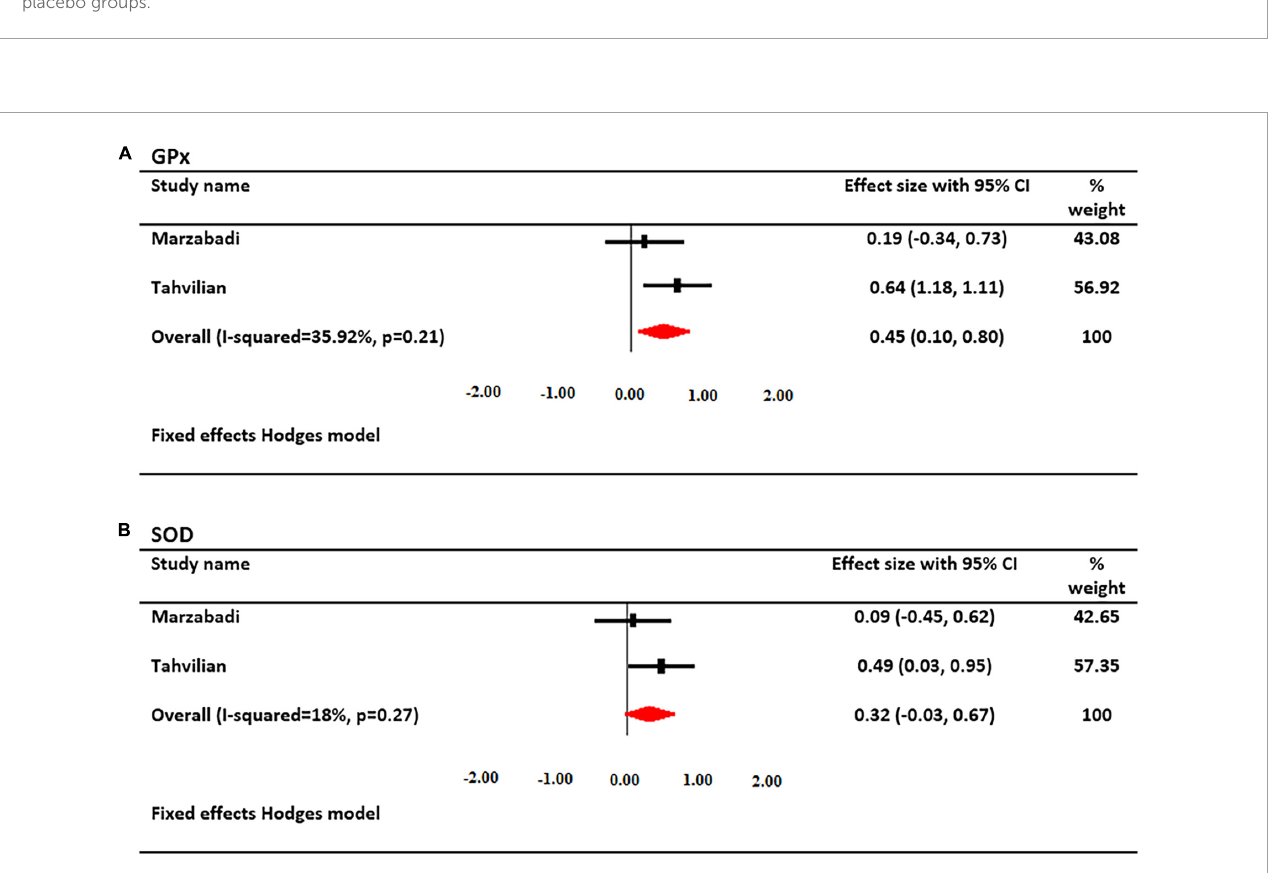
FIGURE6 Forest plot showing the summary effect size for (A) glutathione peroxidase (GPx) and (B) superoxide dismutase (SOD) levels between saffron and placebo